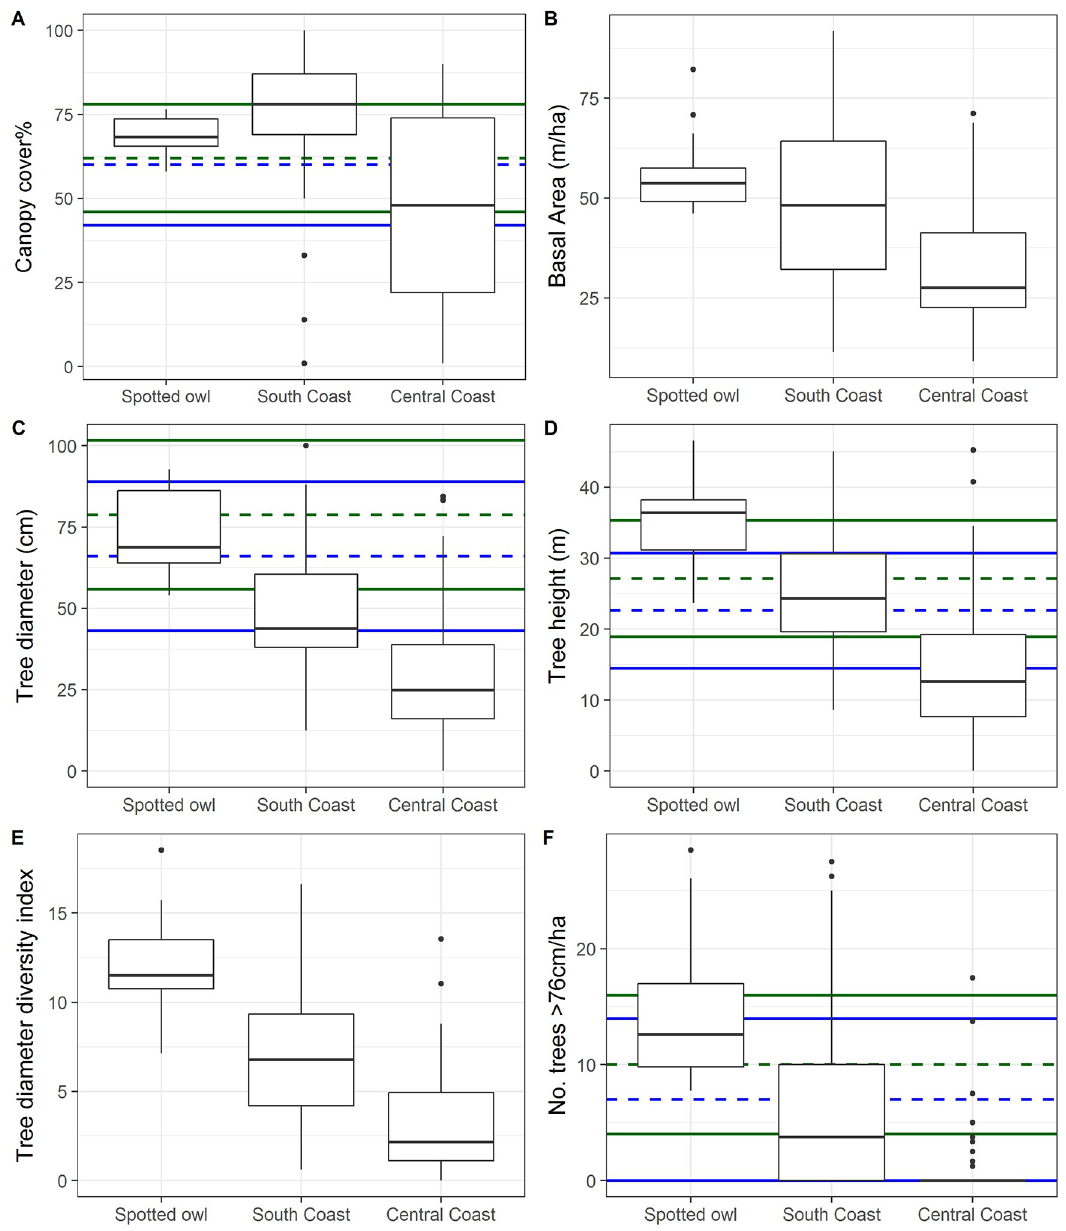
Fig 2. Vegetation data—Tree and canopy. Comparison of tree and canopy metrics at northern spotted owls ( Strix occidentalis caurina ) and a coastal subspecies of Pacific marten ( Martes caurina humboldtensis ) sites in coastal Oregon. Box plots show maximum and minimum values (end of lines or extreme points), first and third quartiles (top and bottom line of box), and the median (line within box). In some cases (A, C, D, F), a variable was also in a top model describing predicted habitat [7]. We show the mean (dashed line) and 95% confidence interval (colored line) for predicted high (blue) and very high (green) quality spotted owl